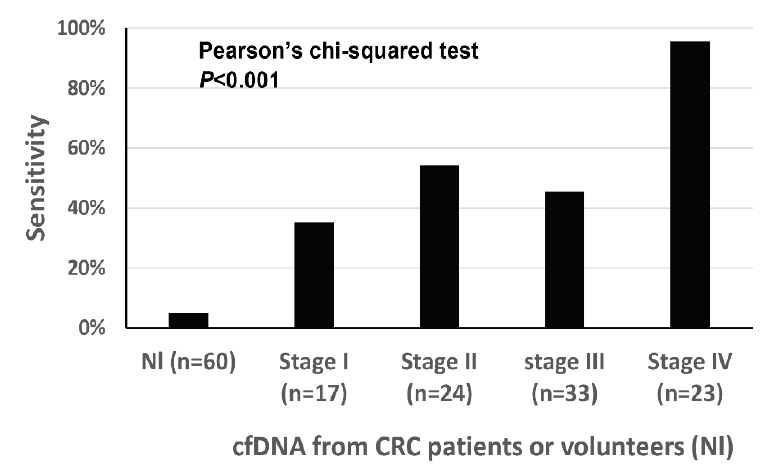
Figure 2. The sensitivity of the five-marker panel for the detection of colorectal cancer (CRC) in cfDNA samples from patients with CRC. Table 3. The number of methylated markers in cfDNA samples in relation to clinicopathological features of colorectal cancer patients ( n = 97).